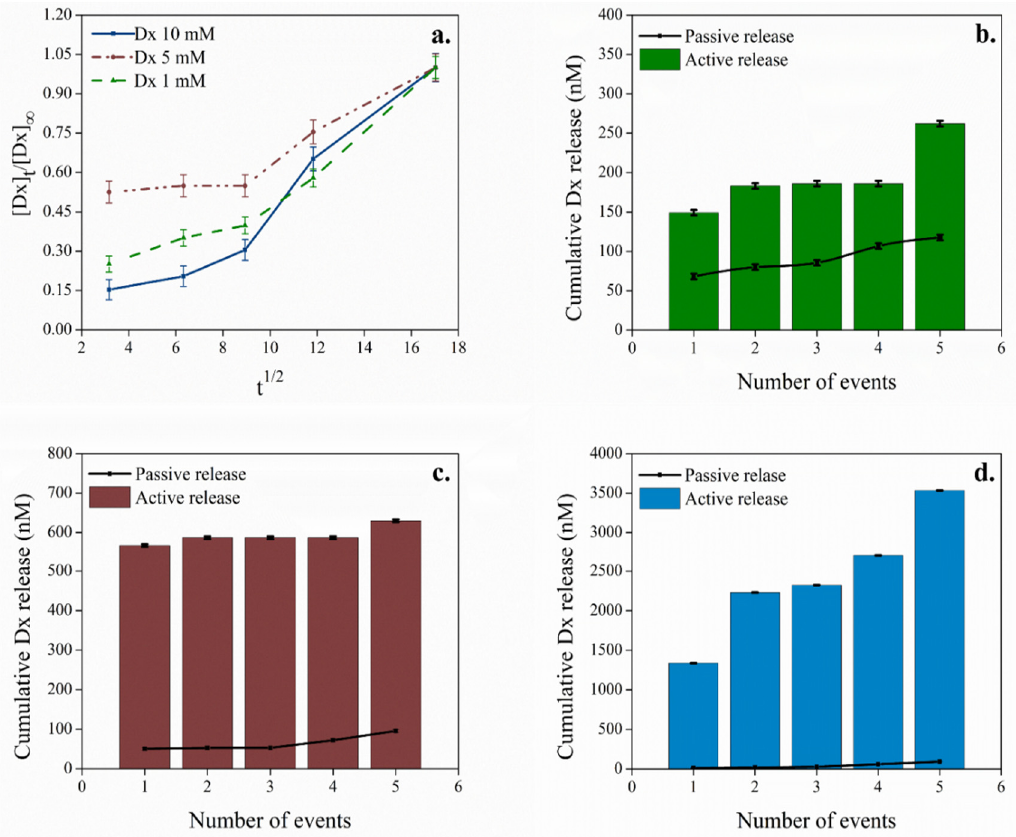
Figure 5. ( a ) The passive release profile of Dx as a function of square root of time, over 300 min from unstimulated electrodes. The active electrically controlled delivery process by stimulation events (columns) compared to the passive release profile (line) using: ( b ) 1 mM, ( c ) 5 mM, and ( d ) 10 mM of Dx in the initial formulation.